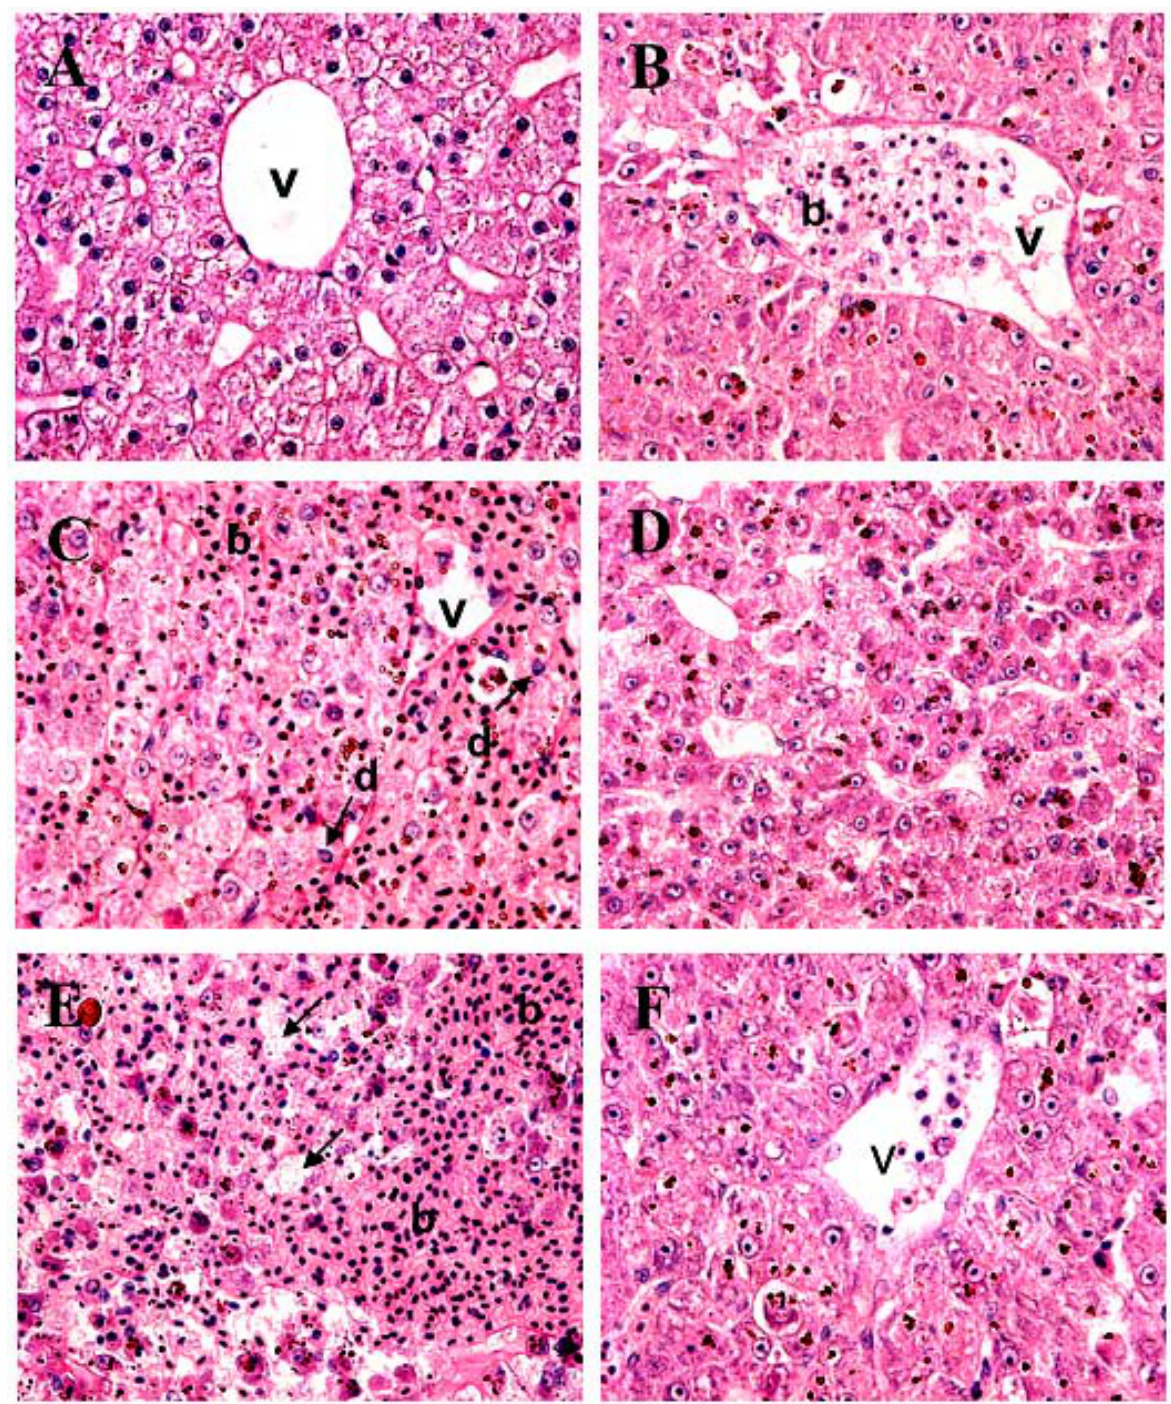
FIGURE 2 . H&E-stained sections of livers from bighead carp injected i.p. with 200 and 500 µg MC-LReq/kg bw, respectively (400× magnification). (A) Control bighead carp; (B–D) bighead carp in 200-µg MC-LReq/kg dose group; (B) 3 h postinjection: rounding and vacuolation of pericentral hepatocytes; (C) 24 h postinjection: hemorrhage and highly condensed chromatin; (D) 48 h postinjection: great recovery of the initial tissue structure and regeneration of hepatocytes; (E and F) bighead carp in 500-µg MC-LReq/kg dose group; (E) 24 h postinjection: extensive hemorrhage and tissue damage involved the whole liver with loss of nuclei and lysis of membranes (arrows); (F) 48 h postinjection: obvious recovery of hepatocytes. b, blood cells; d, condensed chromatin, typical of apoptosis; v, central